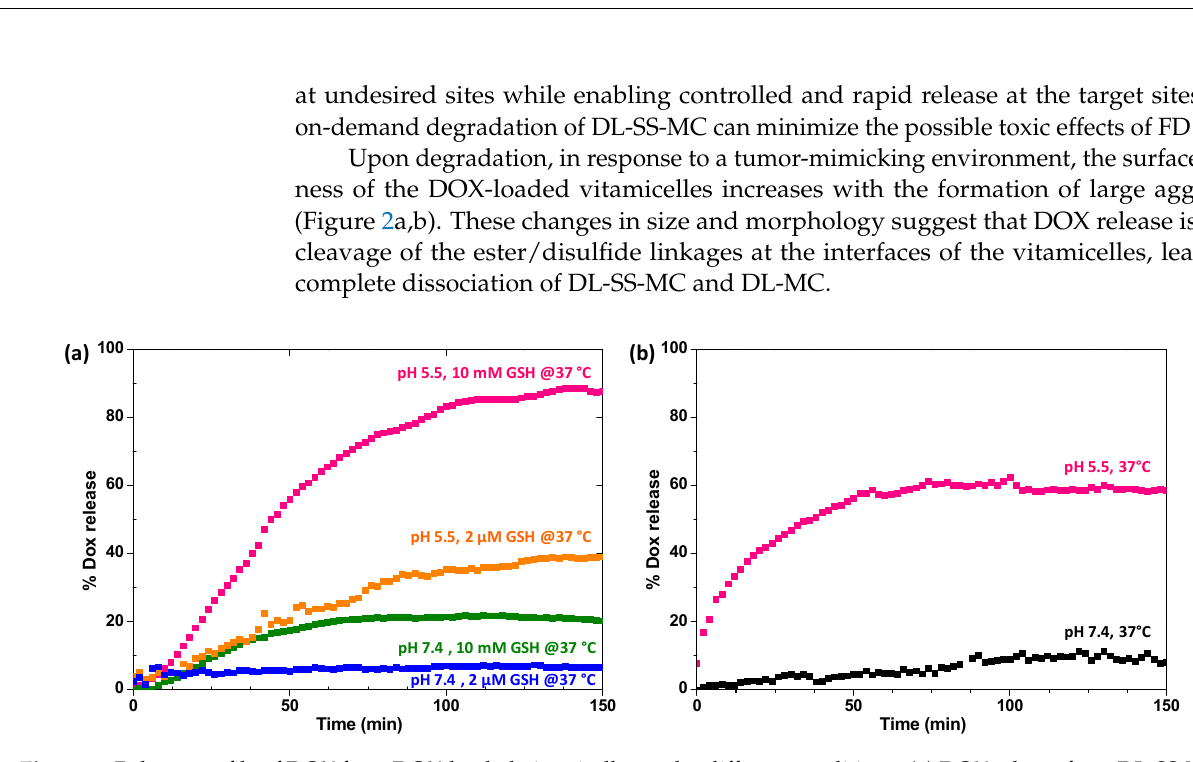
Figure 4. Release profile of DOX from DOX-loaded vitamicelles under different conditions. ( a ) DOX release from DL-SS-MC in PBS buffer at 37 °C at pH 5.5/10 mM GSH; pH 5.5/2 μ M GSH; pH 7.4/10 mM GSH; and pH 7.4/2 μ M GSH. ( b ) DOX release from DL-MC in PBS buffer at 37 °C at pH 5.5/pH 7.4.